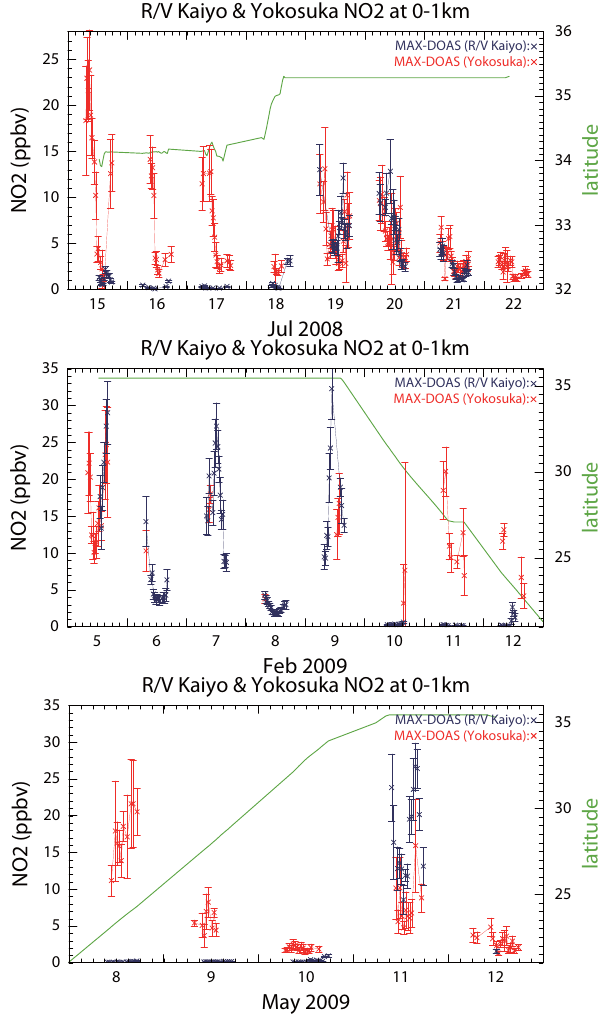
Fig. 4. NO 2 variations observed by MAX-DOAS on the R/V Kaiyo (blue) and at Yokosuka (red) for 0–1km during the three observa- tion periods, focusing on the Japan region. Error bars indicate the total error of NO 2 measurements. Also shown is the latitude of the vessel (green